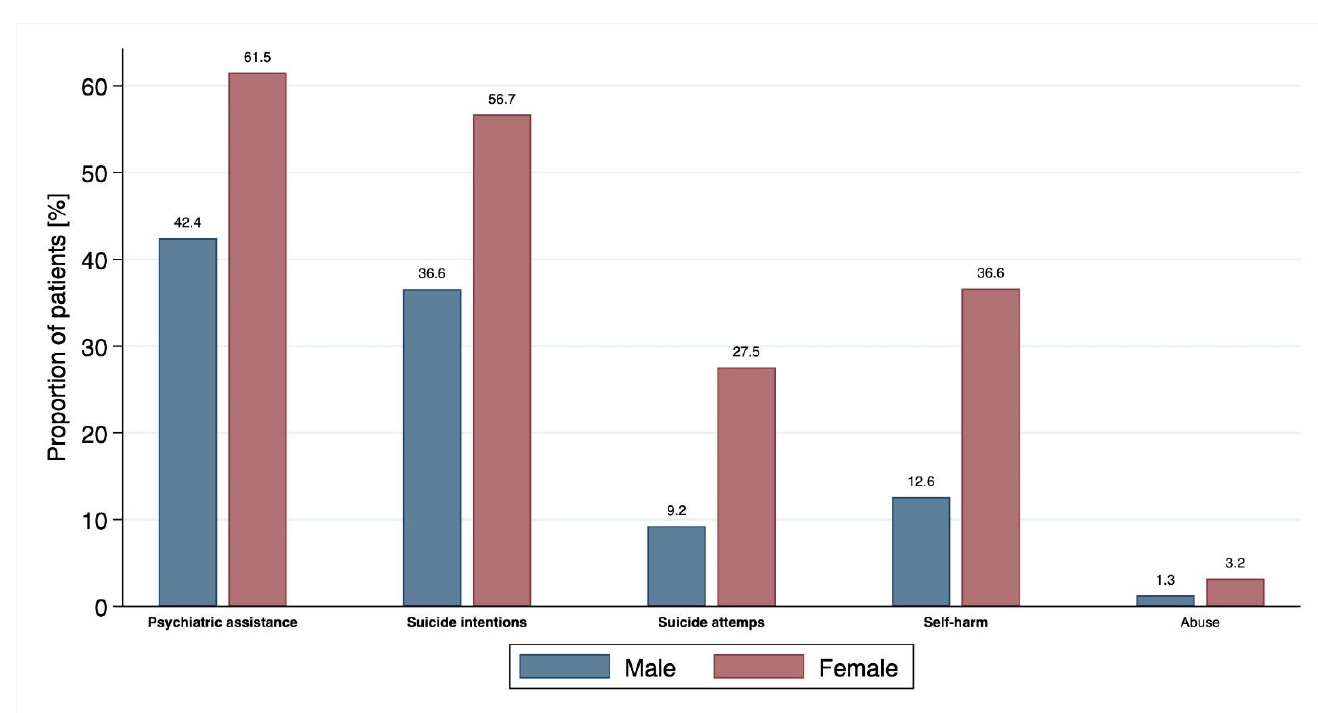
Figure 3. Sex difference of history of psychiatric problems. Variables with significant differences ( p < 0.05) between males and females are shown in bold. Table 3. History of pre-existing psychiatric diagnoses.